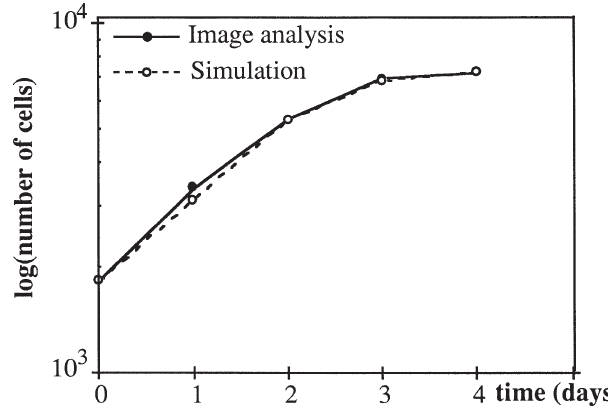
Fig. 6. Proliferating curves (semilogarithmic representation). The plain curve (—) represents the results of the image analysis. The dashed curve (- - -) represents the results of the simulation